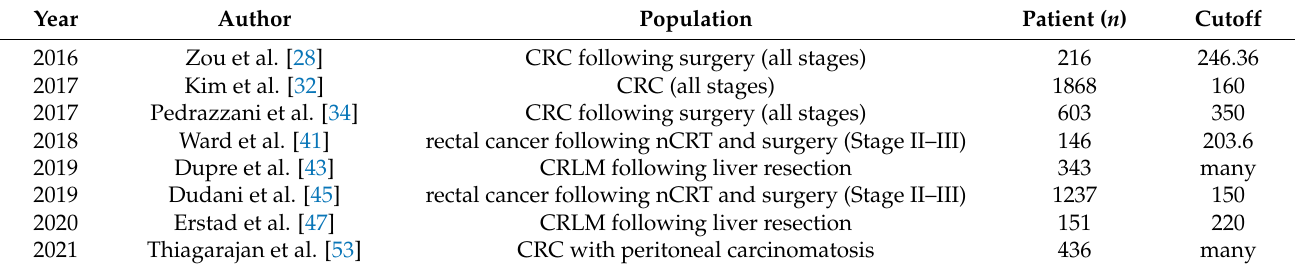
Table 6. Platelet–lymphocyte ratio (PLR) in previous report on colorectal